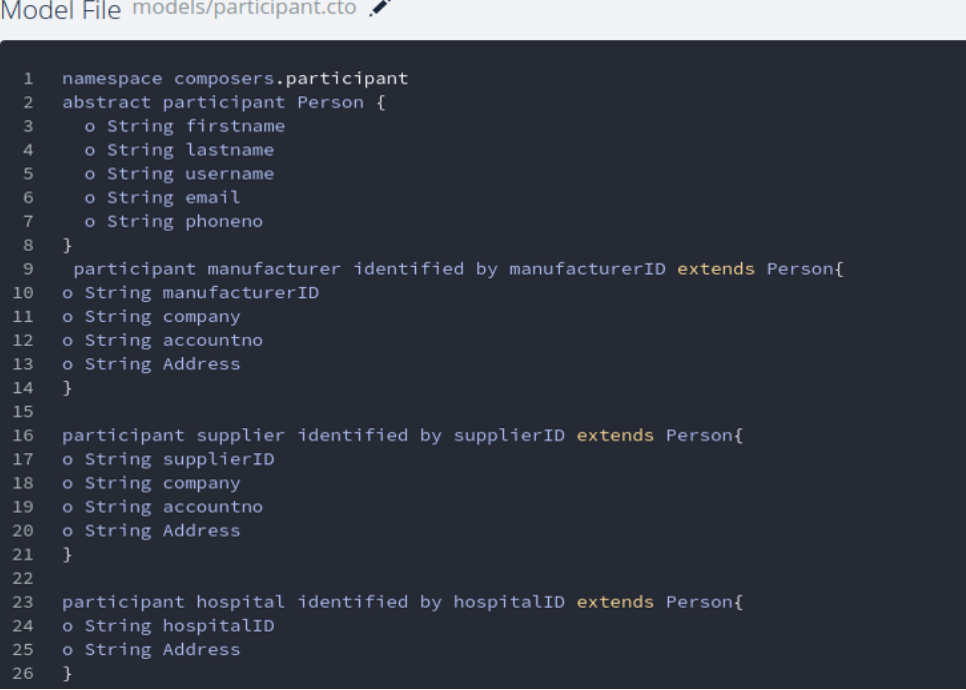
Figure 10. Participants definition in Hyperledger composer.